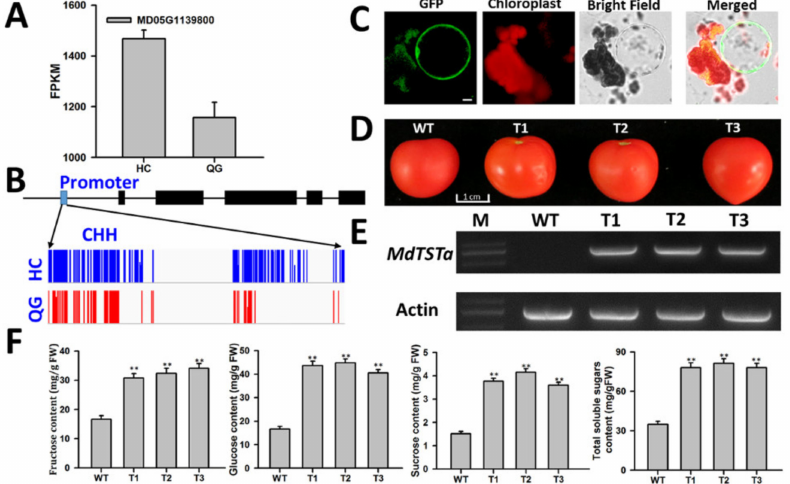
Figure 5. Functional characterization of MdTSTa . ( A ) MdTSTa expression levels in ‘HC’ and ‘QG’ mature fruits. ( B ) Differences in the methylation level of the MdTSTa promoter in the CHH context between ‘HC’ and ‘QG’ mature fruits. ( C ) Tonoplast localization of the MdTSTa-GFP fusion protein in vacuoles, which were obtained after transiently transformed N. benthamiana protoplasts were lysed. Bars represent 10 µ m. ( D ) Mature tomato fruits from wild-type and 35S: MdTSTa transgenic lines. ( E ) MdTSTa expression in wild-type and transgenic tomato based on RT-PCR data. ( F ) Soluble sugar contents in the mature tomato fruits of wild-type and transgenic lines. WT: wild-type; T1, T2, and T3: 35S: MdTSTa transgenic lines. Double asterisks (**) represent significant differences between wild-type and transgenic fruits ( t -test, p <